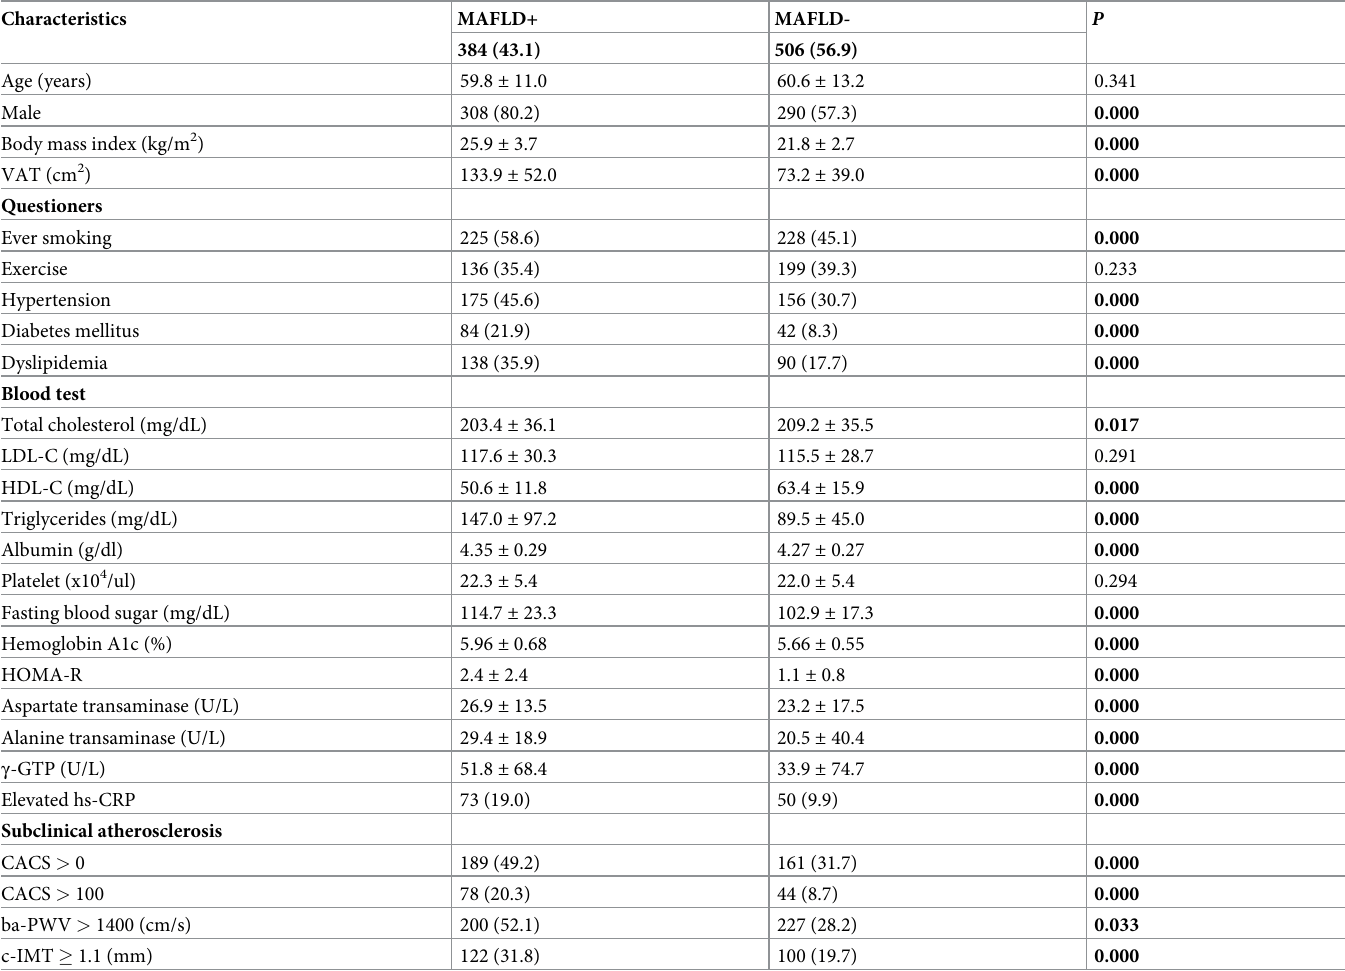
Table 1. Clinical characteristic by presence of